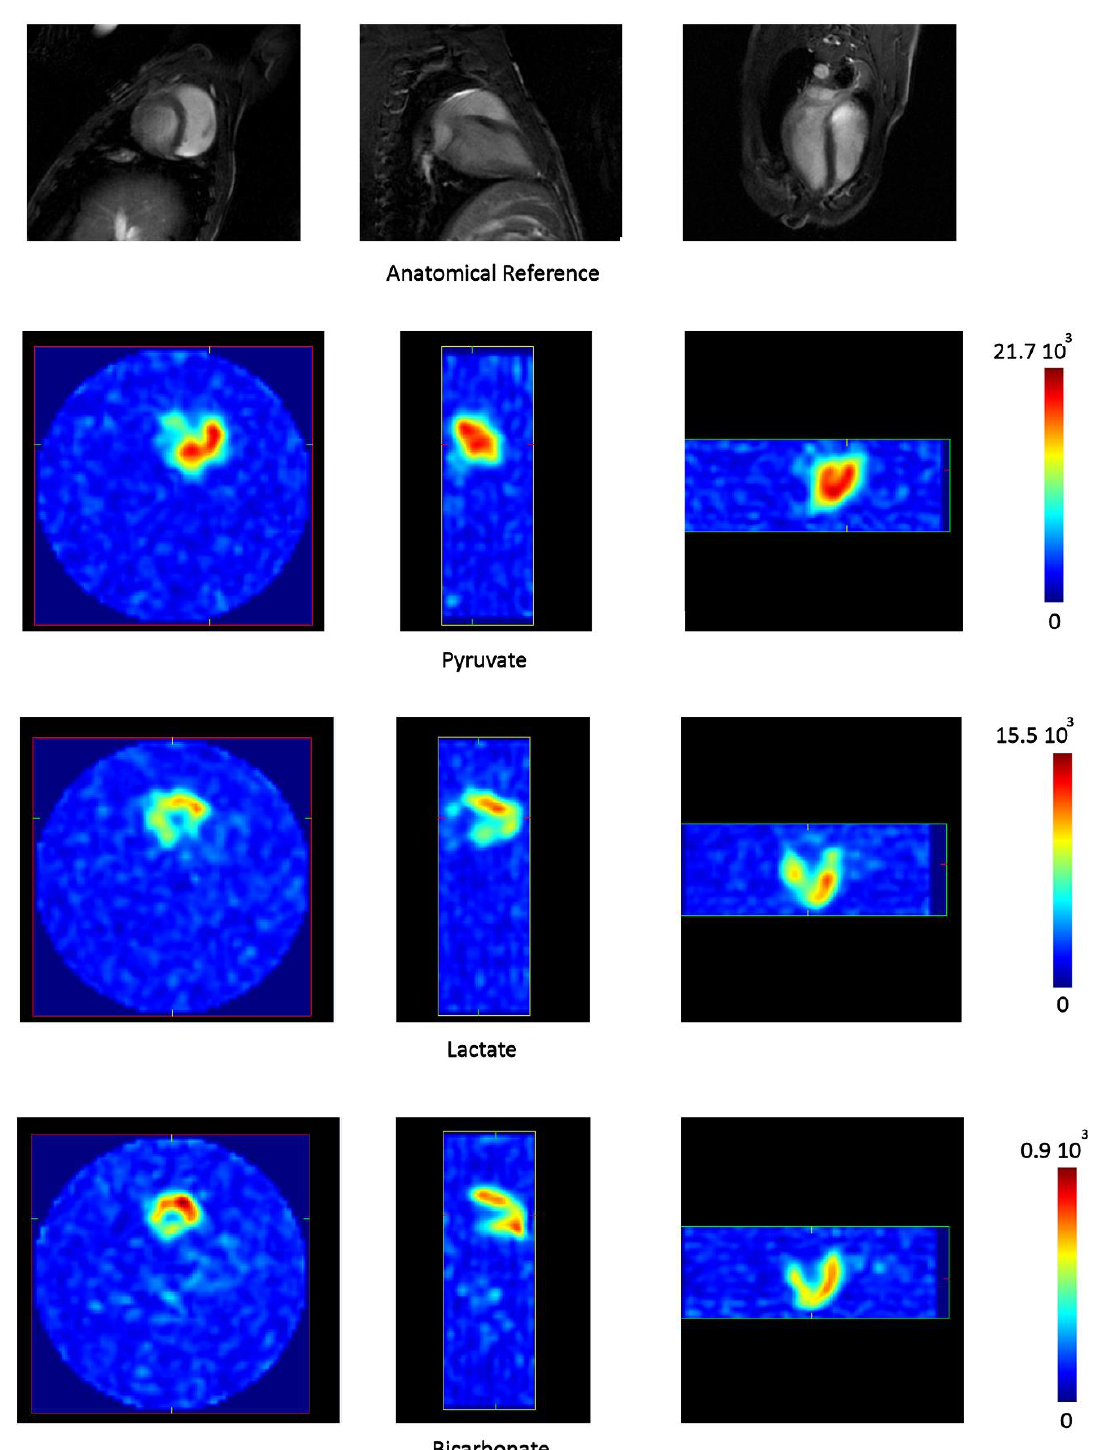
Figure 12. Triplanar views of pyruvate, lactate, and bicarbonate on three main heart axes. Reprinted by permission from: Frijia et al., Journal of Medical and Biological Engineering 2016 [68].